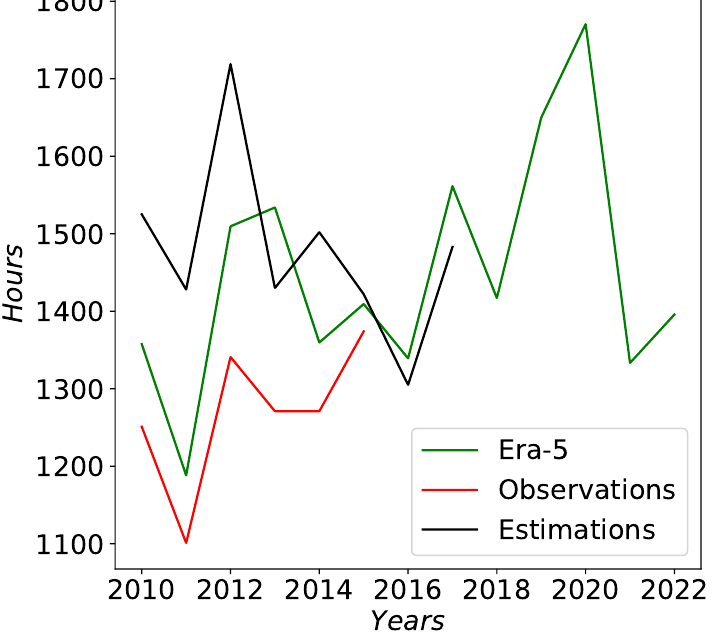
Figure 11. Annual changes in amount of hours from visual observations at the BTA with the hours estimated from Era-5 reanalysis data. The amount of observation time at the BTA according to the operation service is shown by the black line. The amount of observation time at the telescope according to astronomical observations is shown by the red line. The value in 2022 is the forecast variable (regression